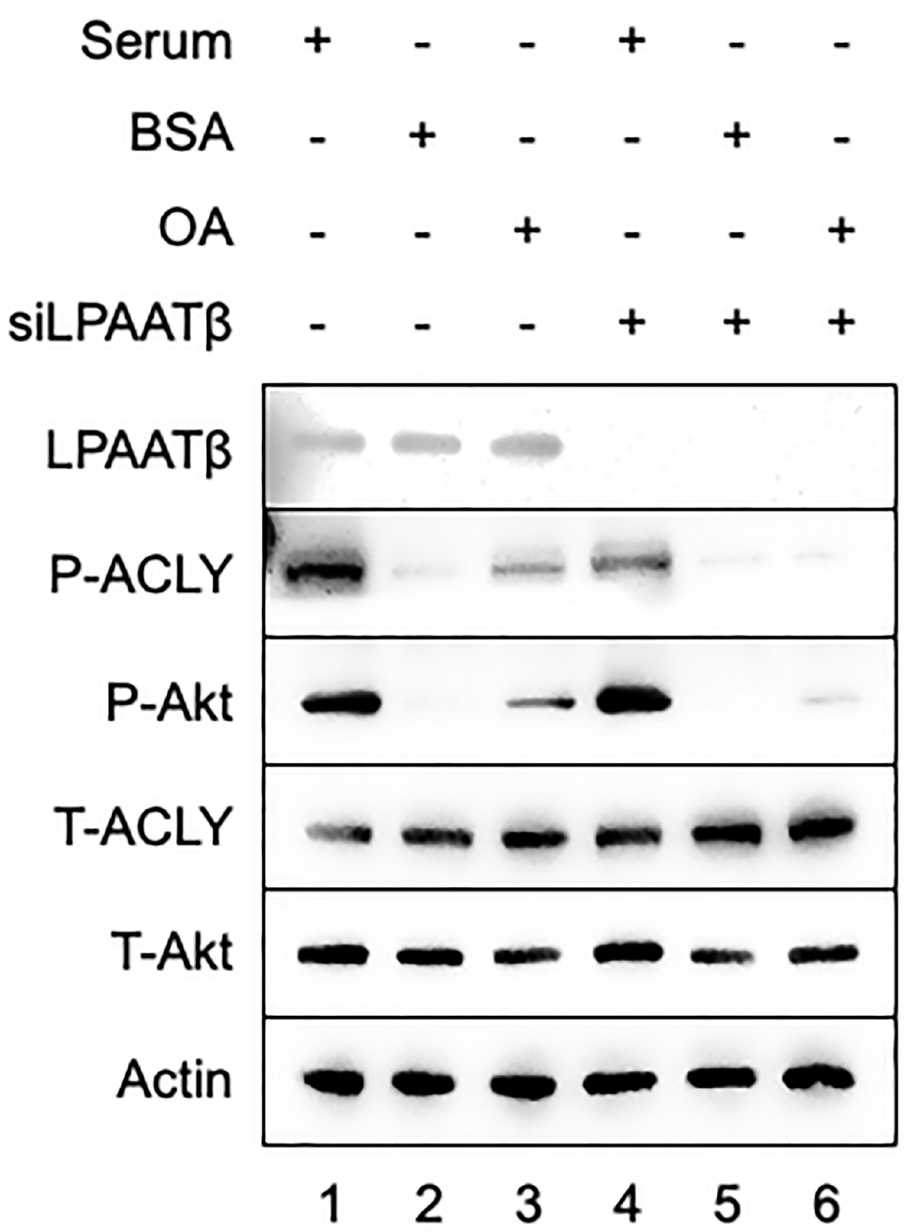
Fig 2. mTORC2 mediated activation of ACLY through production of de novo PA in presence of oleic acid. HCT116 cells were plated at 50% confluency. After 24 hr, cells were transfected with LPAAT- β siRNA (100 nM) (+) or non-targeting (-) siRNA for 72 hr. At 48 h point, the media was changed to serum free media for overnight. OA (10 μ M):BSA in a 2:1 ratio was added in presence or absence of LPAAT- β . Lysates were collected and analyzed for protein expression. The Western blots shown are representative of experiments repeated at least three